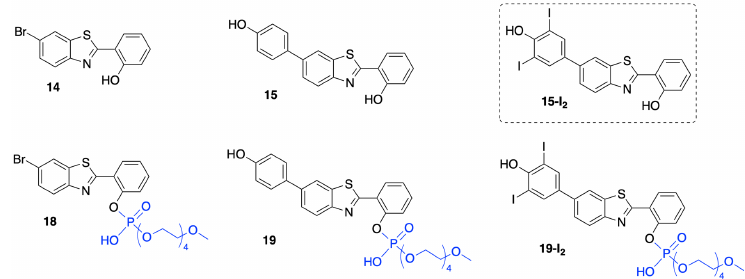
Figure 5. Structures of HBT derivatives and phosphodiester counterparts.